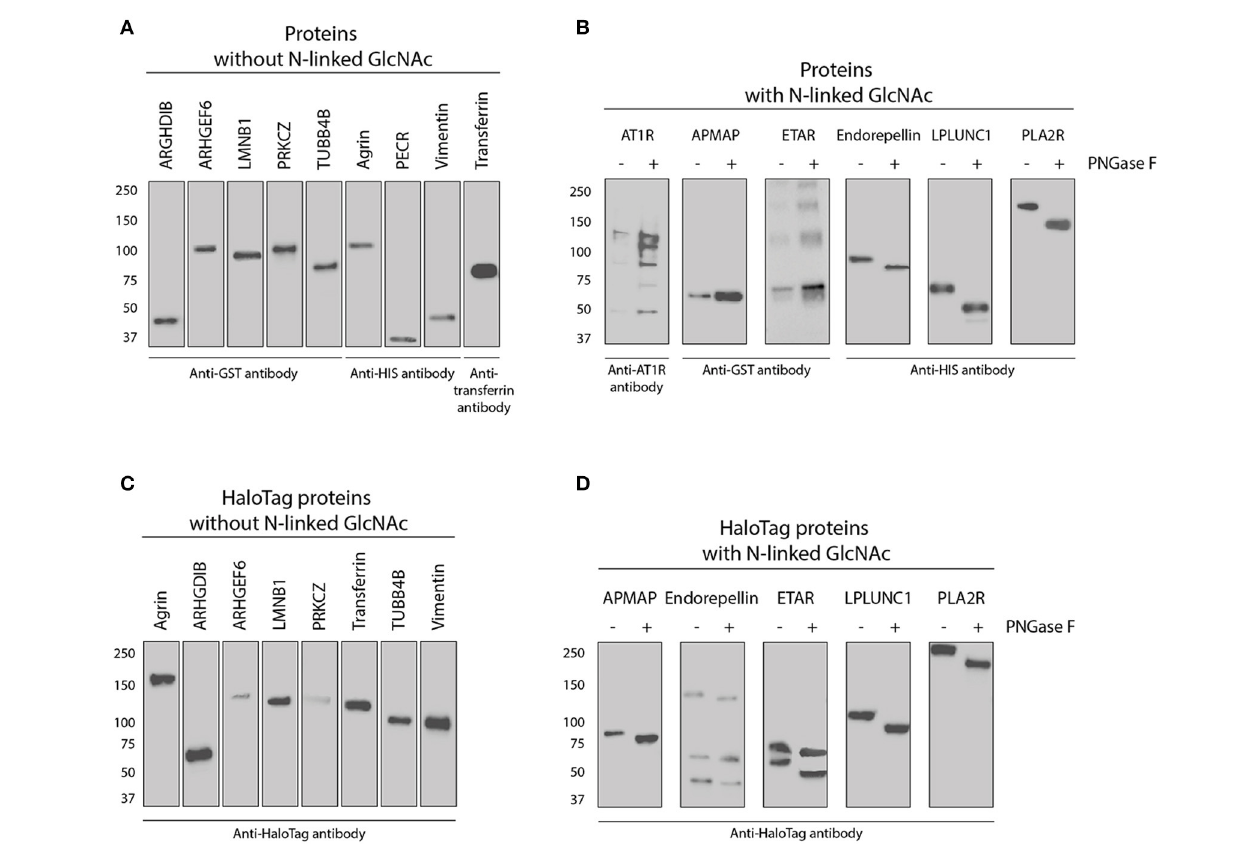
FIGURE 4 | Western blot of all purchased and in-house produced proteins used for direct- and HaloTag coupling to microspheres. (A) Nine purchased proteins without an N-Acetylglucosamine (N-GlcNAc) according to UniProt (see also Table 2 ). Proteins were detected with either tag or protein specific antibodies as indicated. (B) Five purchased and one in-house produced proteins (PLA2R) have an N-GlcNAc according to UniProt and were therefore treated with PNGase F to check for this glycosylation. Proteins before and after treatment were detected with either tag or protein specific antibodies as indicated. (C) Eight in-house produced HaloTag proteins without a GlcNAc according to UniProt were all stained with anti-HaloTag antibody. (D) Five-in-house produced HaloTag proteins with an N-GlcNAc according to UniProt were treated with PNGase F to check for this glycosylation. These proteins were all detected before and after treatment with anti-HaloTag